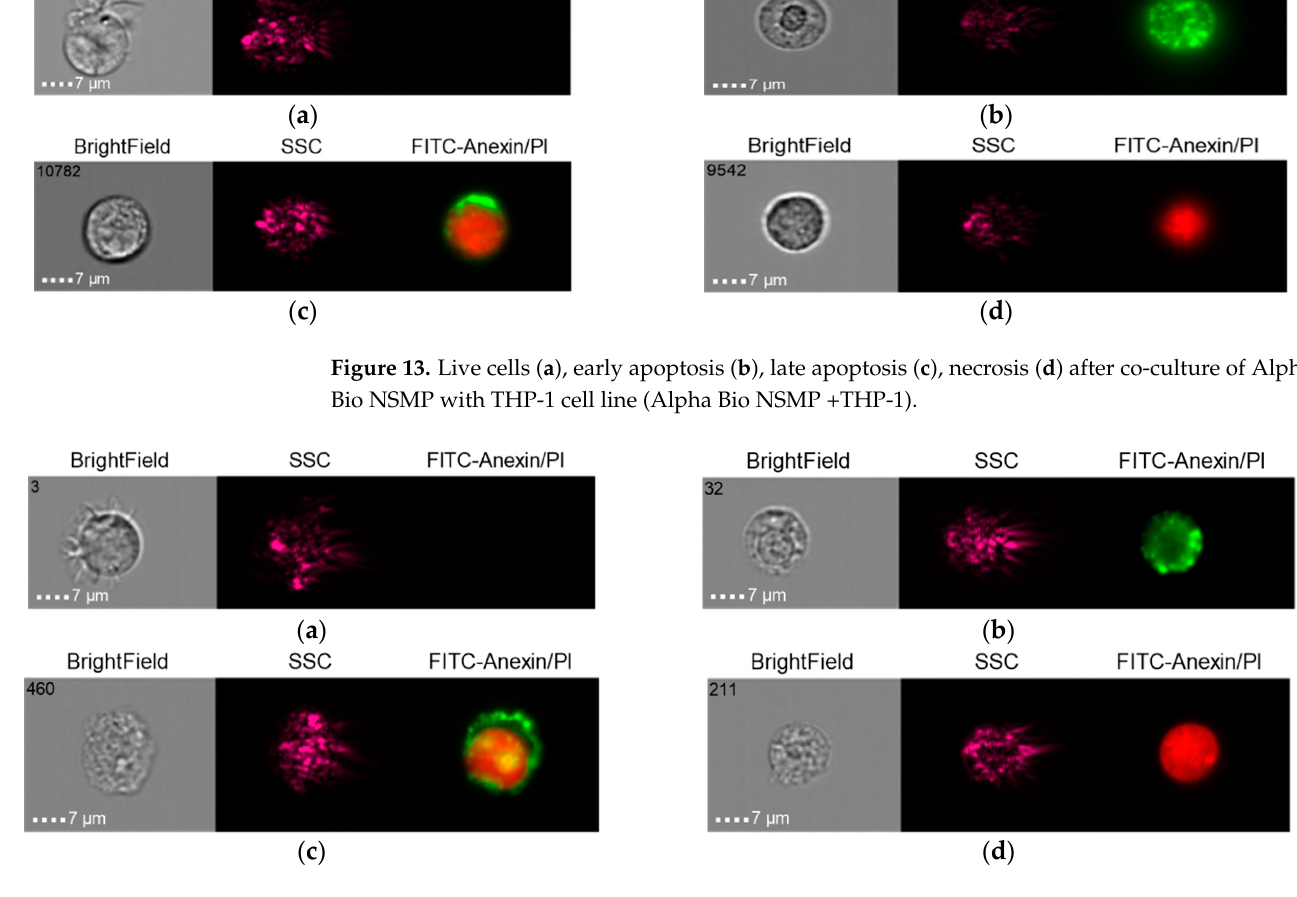
Figure 14. Live cells ( a ), early apoptosis ( b ), late apoptosis ( c ), necrosis ( d ) after co-culture of THP-1 cell line with healthy donor serum without previous dental implantation (HDS + THP-1).